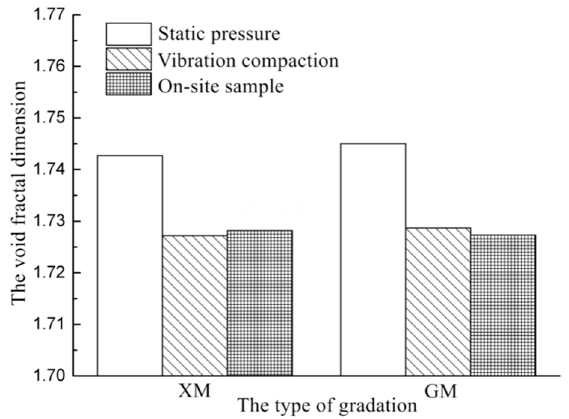
Figure 8. Fractal dimension of void cement stabilized macadam mixture.